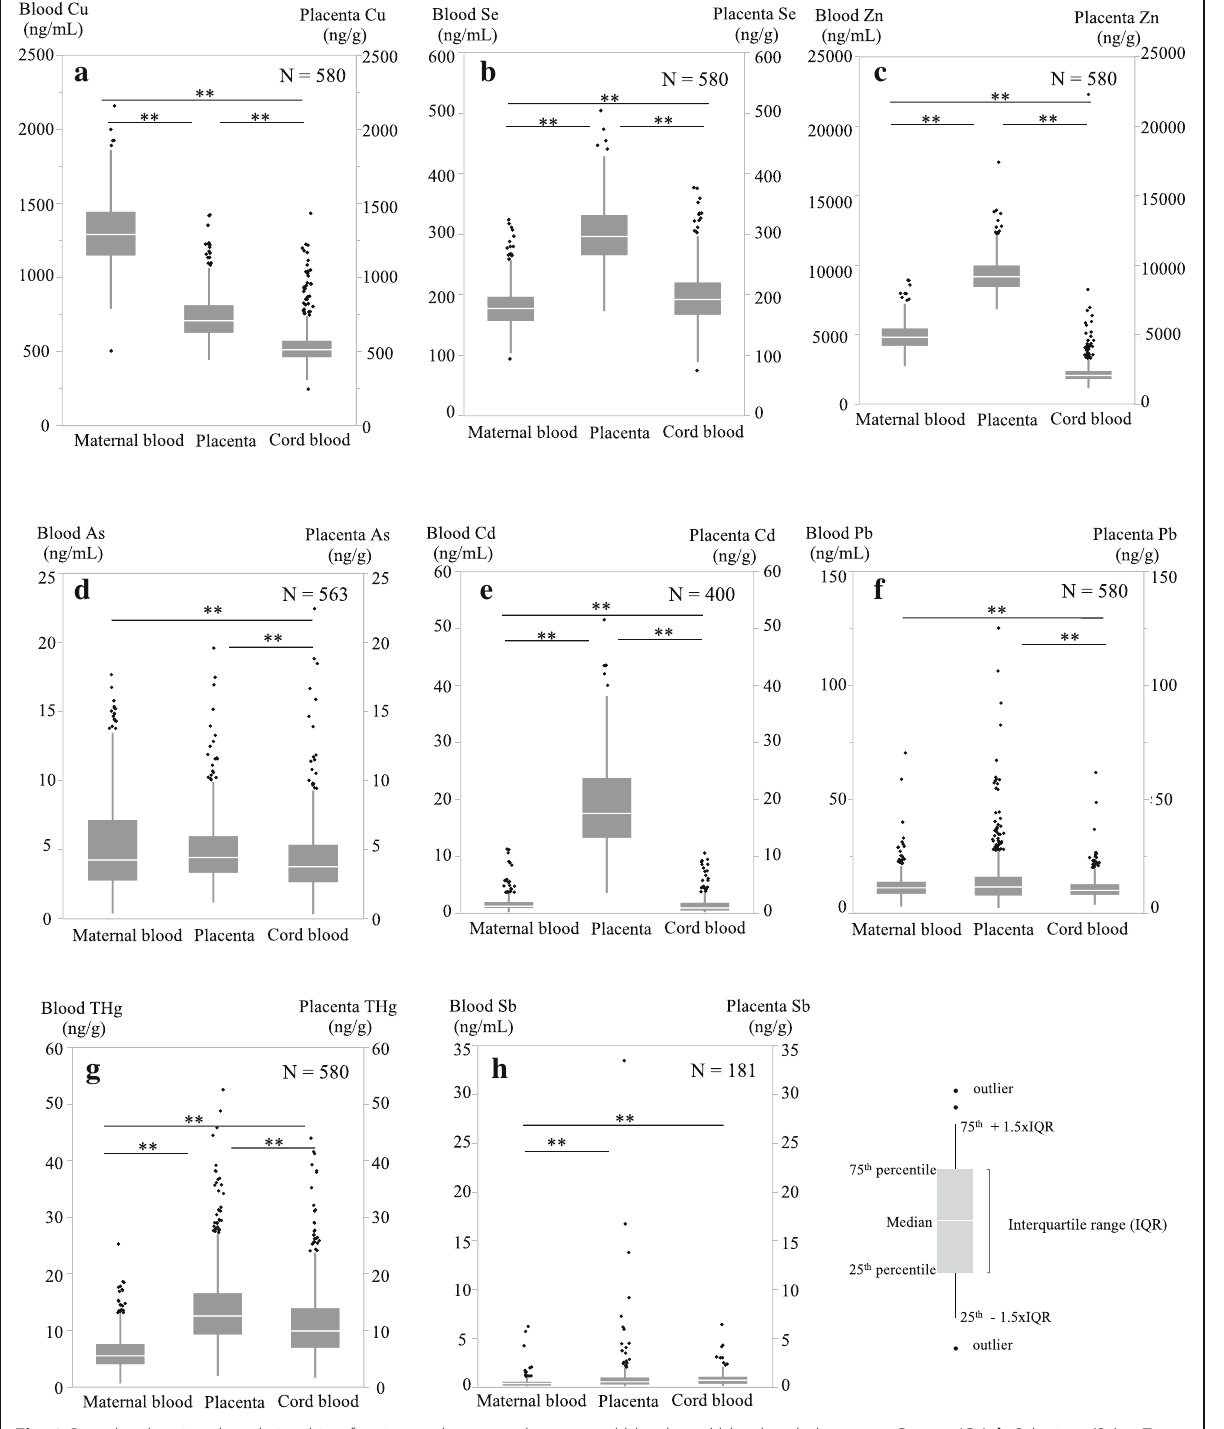
Fig. 2 Box-plot showing the relationship of toxic metals among the maternal blood, cord blood and placenta. a Copper (Cu). b Selenium (Se). c Zinc (Zn). d Arsenic (As). e Cadmium (Cd). f Lead (Pb). g Total mercury (THg). h Antimony (Sb). The number of samples above LOD in the maternal blood, cord blood and placenta. Statistical analyses were performed by nonparametric Kruskal-Wallis followed by Dunn test. Significantly different ( ** P <0.01), As and Pb: maternal blood (MB) and placenta (PL)>cord blood (CB), Cd: PL>MB>CB, Cu: MB>PL>CB, Se: PL >CB>MB, Sb: PL and CB>MB, THg: PL>CB>MB, Zn: